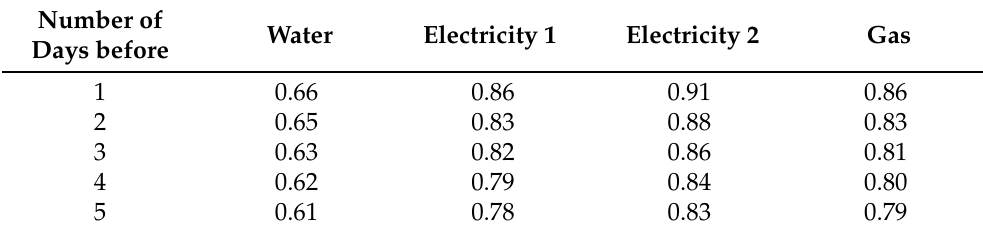
Table 2. Values of existing correlations between readings at 12:00 A.M. (midday) and readings that occurred at the same time on previous